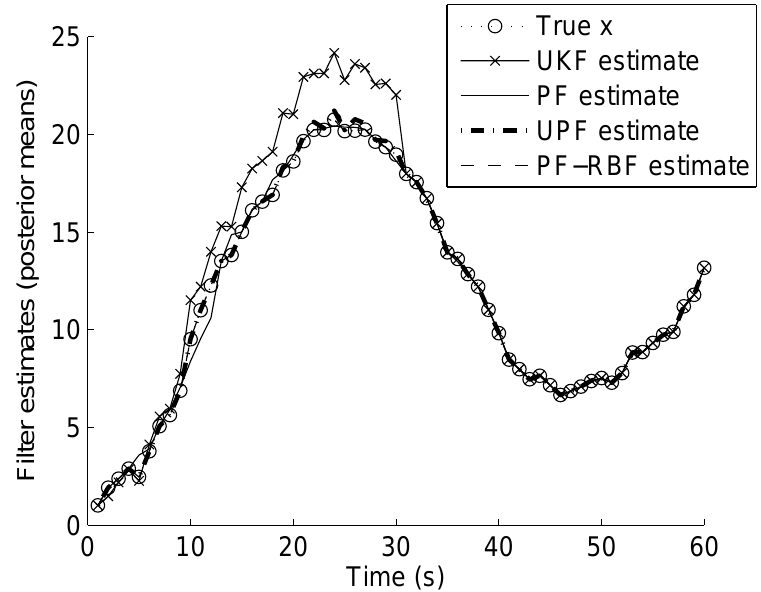
Figure 2. Plot of estimated results generated from a single run of the different filters with non-stationary observation